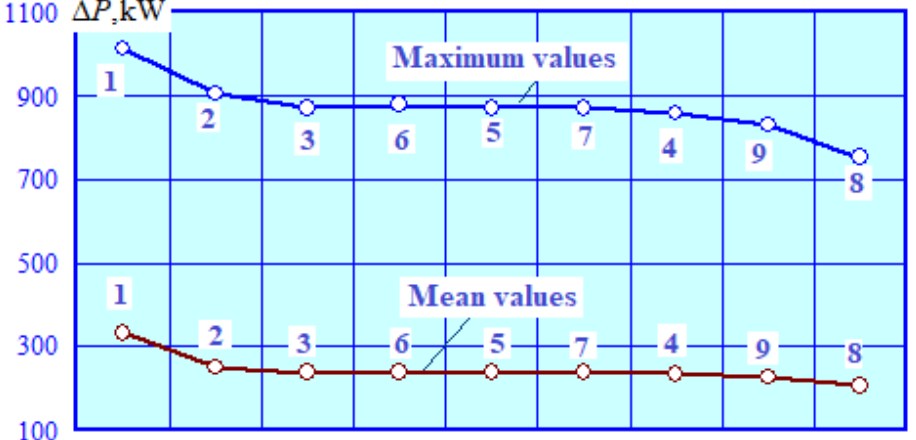
Figure 17. Power losses in the traction network of the middle inter-substation area—callout numbers correspond to those in Figure 15.